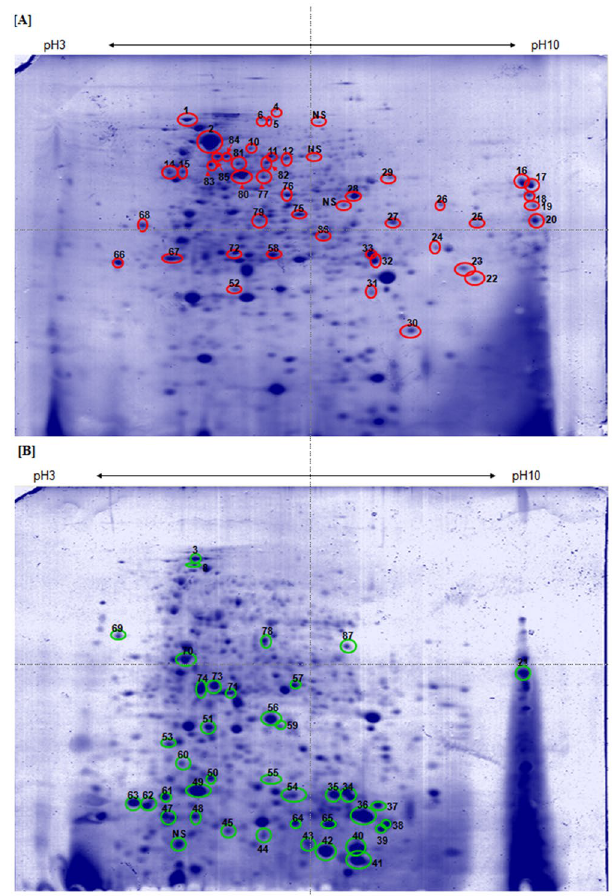
Figure 2. Analysis of Bp MARAN and Bp mouse-adapted whole bacterial protein by 2-DE. The whole bacteria of Bp MARAN (panel A) and Bp mouse-adapted (panel B) grown to mid-logarithmic phase in LB medium were prepared using sonication method and analysed using 2-DE. A total of 450 μ g of whole bacteria was separated on an IPG strip pH 3–10 in the first dimension, followed by the separation on SDS-12% PAGE for the second-dimension separation. The separated proteins were detected by CBB G-250 staining. Marked spots indicate proteins that were identified (red: up-regulated; and green: down-regulated). NS refers to spots that were not possibly identified by